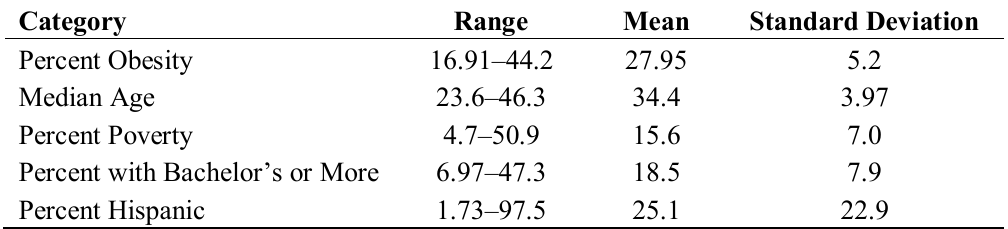
Table 1. Descriptive Analysis on 91 Counties in Texas.